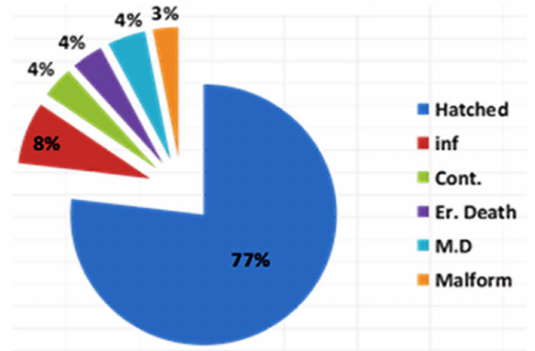
Figure 12. Average breakout results of the unhatched eggs during the four full incubation trials showing the percentage of hatched, infertile (inf), contaminated (Cont.), early death (Er. Death), middle death (M.D) and malformed